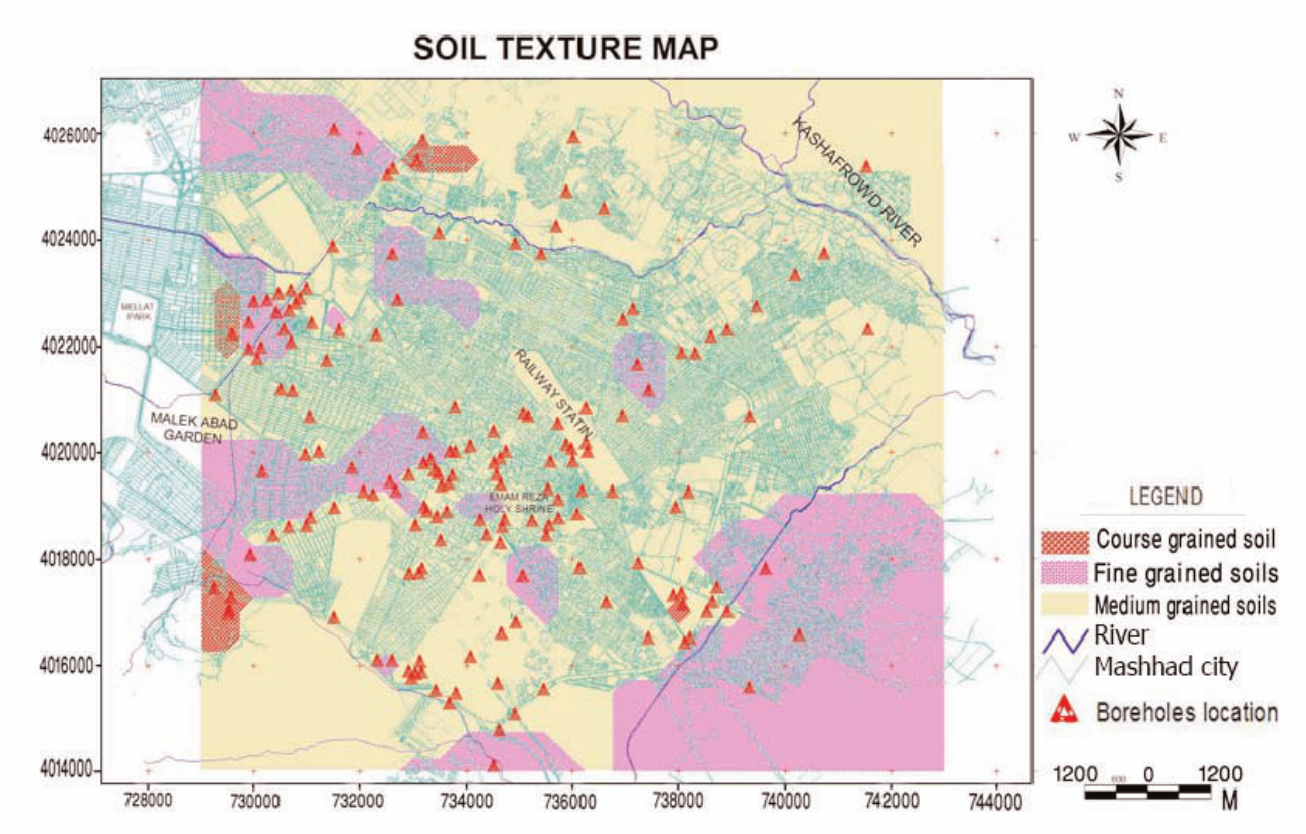
Figure 2. Surface soil texture for Mashhad